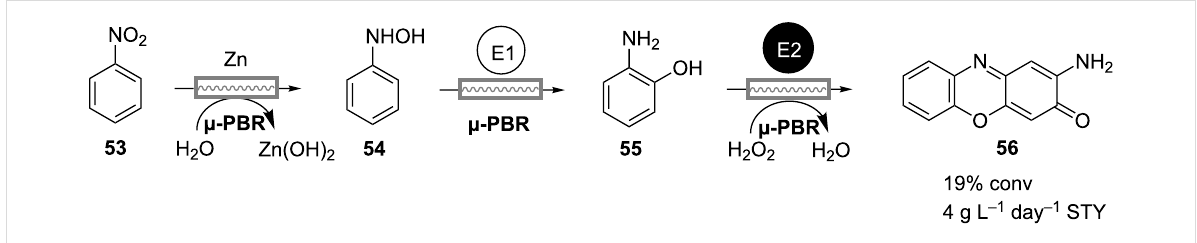
performed in a fully automated flow reactor consisting of three types of prepacked columns. The first two columns